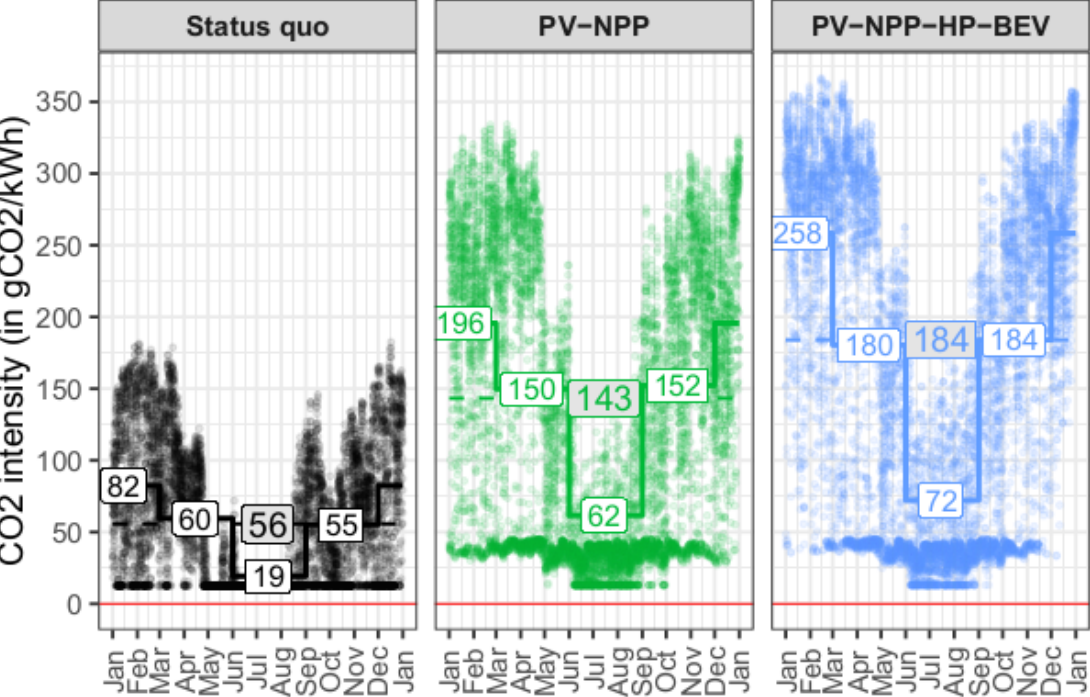
Figure 25. Hourly CO 2 intensities for the three scenarios in Table 2 calculated with balancing method “BM4” (see Section 2.5.2). Demand-weighted seasonal averages and the annual average are indicated as lines and